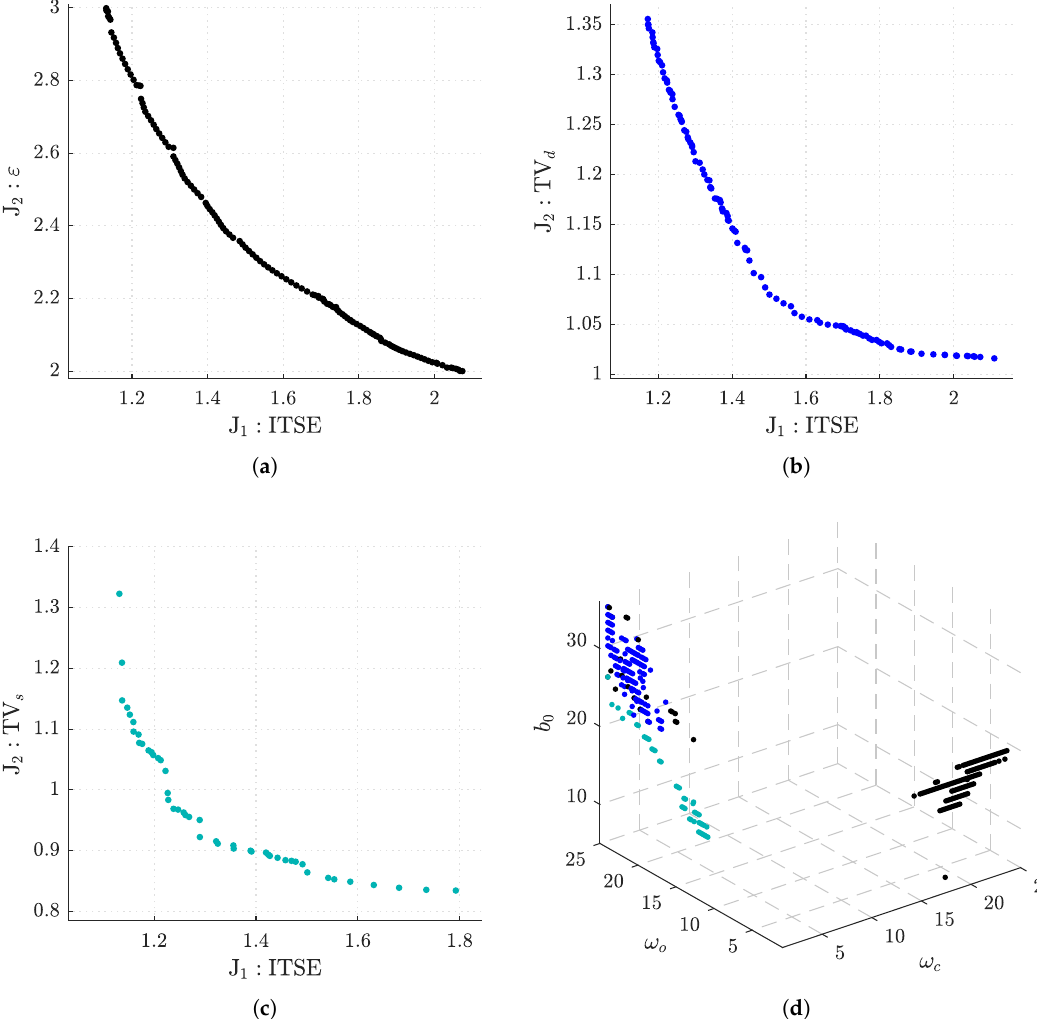
Figure 5. Pareto Fronts and Pareto Sets approximations for minimization of two design objectives J 1 and J 2 . ( a ) the Pareto Front approximation for the simultaneous minimization of ITSE for disturbance rejection and robustness. ( b ) the Pareto Front approximation for minimization of ITSE and TV for disturbance rejection (TV d ). ( c ) the approximation of the Pareto Front when the ITSE for disturbance rejection is minimized simultaneously with the TV of the unitary setpoint (TV s ). ( d ) the Pareto Sets approximations for the three said